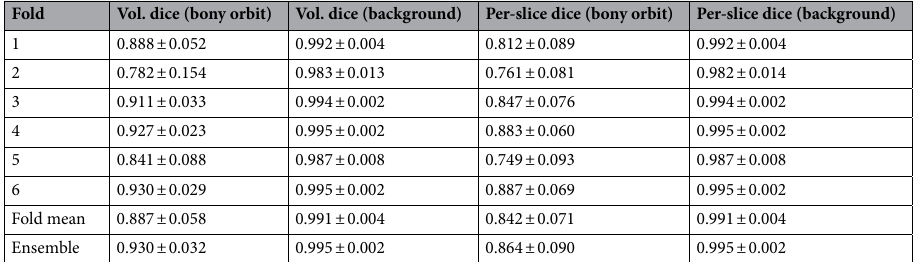
Table 3. Results summary with the mean ± standard deviation for volumetric and per-slice Dice for the CT dataset. The values for the individual folds are presented along with their mean and the ensemble (based on majority